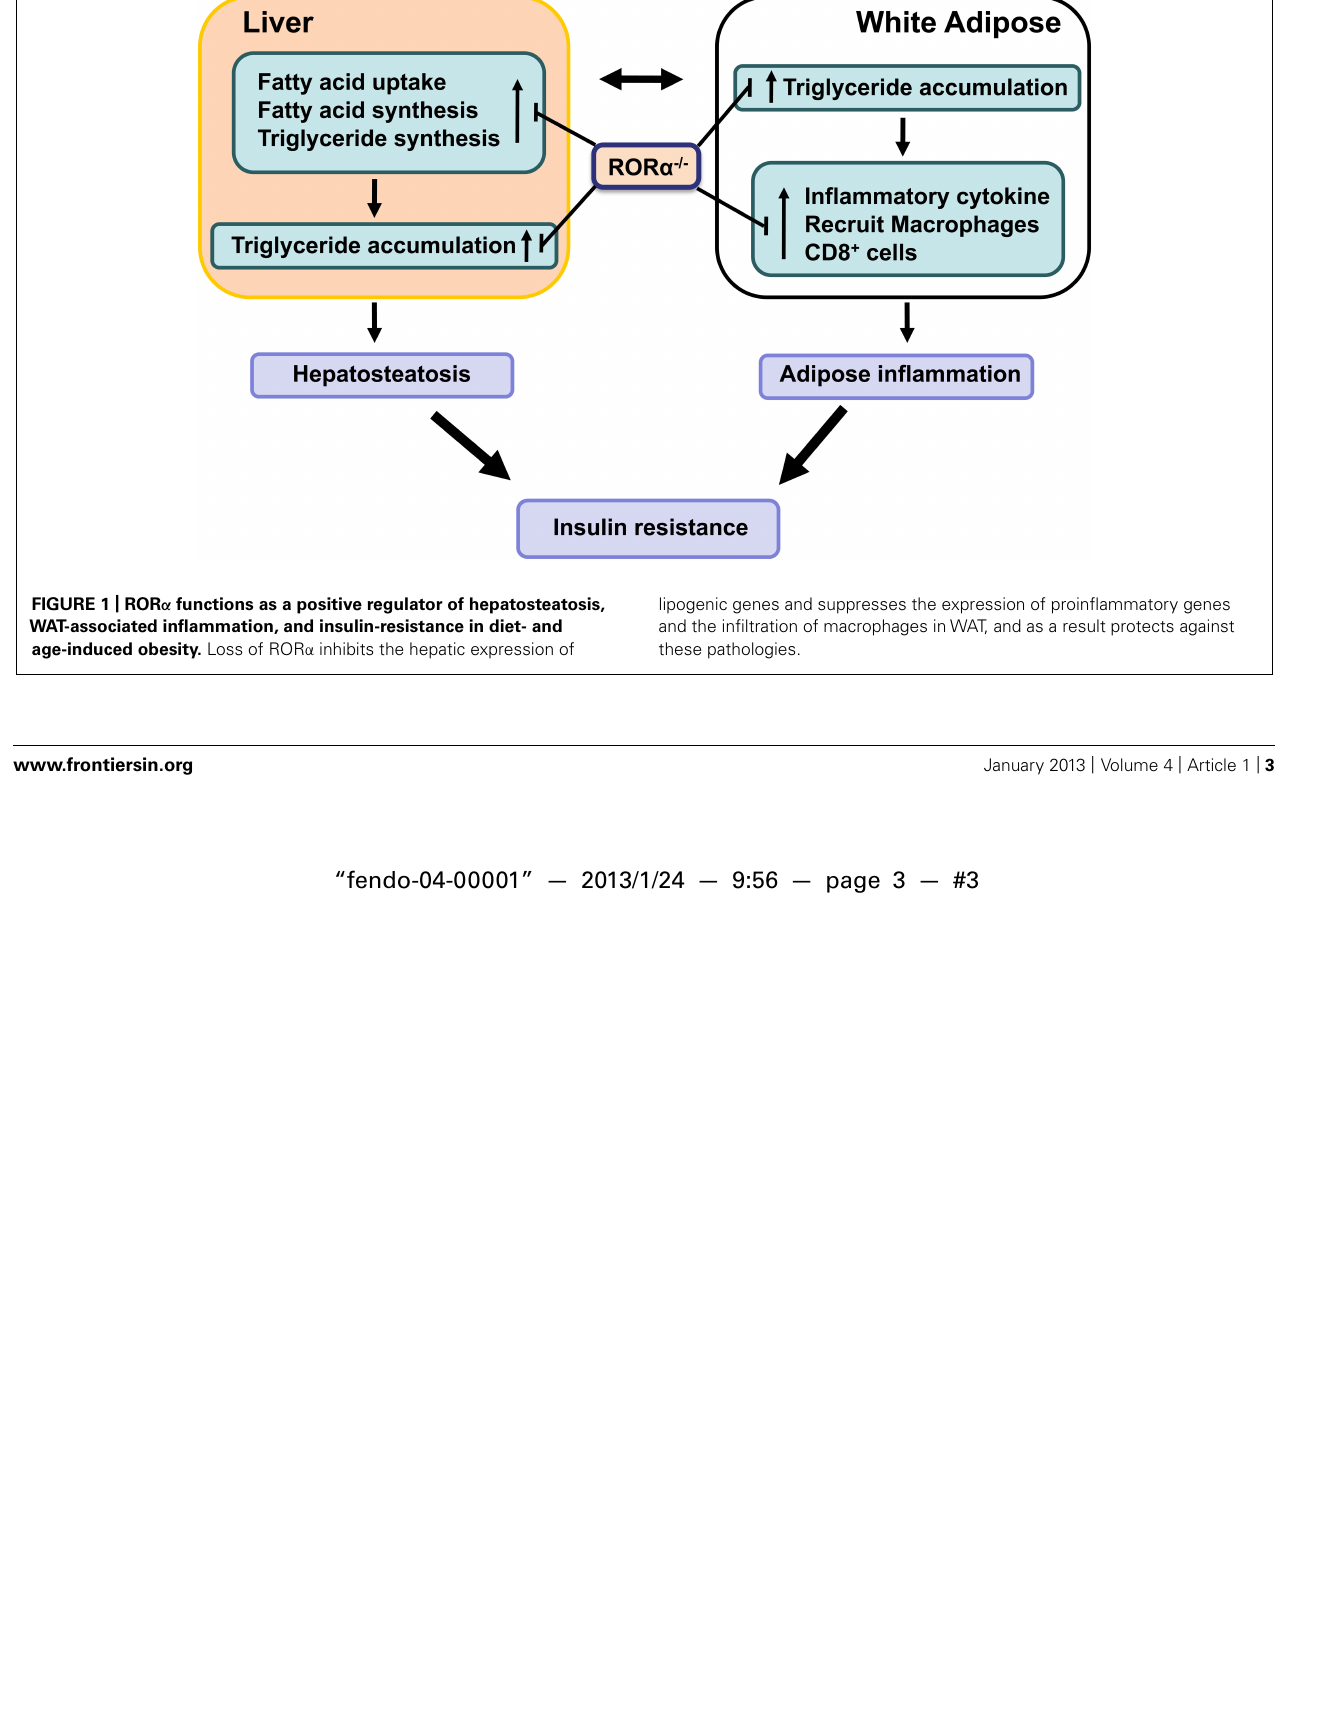
FIGURE 1 | ROR α functions as a positive regulator of hepatosteatosis, WAT-associated inflammation, and insulin-resistance in diet- and age-induced obesity. Loss of ROR α inhibits the hepatic expression of